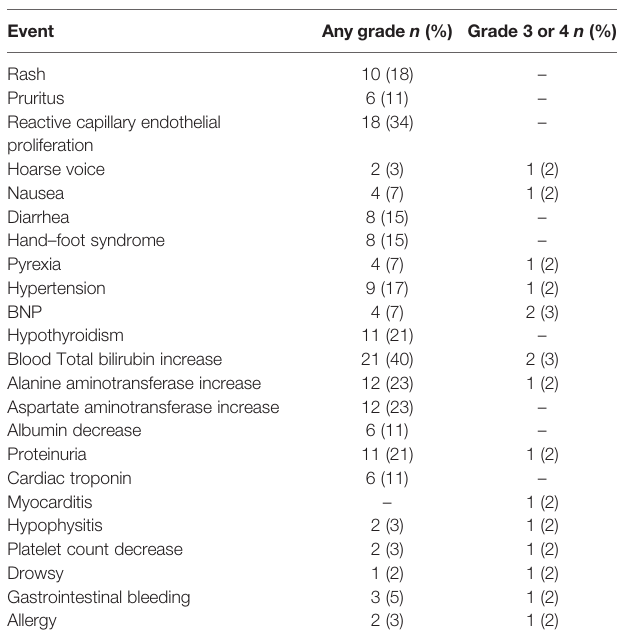
TABLE 3 | Adverse events.